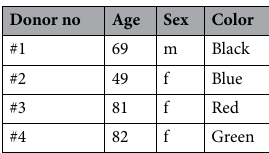
Table 1. Information on each specific donor. The color column defines each data point in Figs. 4, 5 and